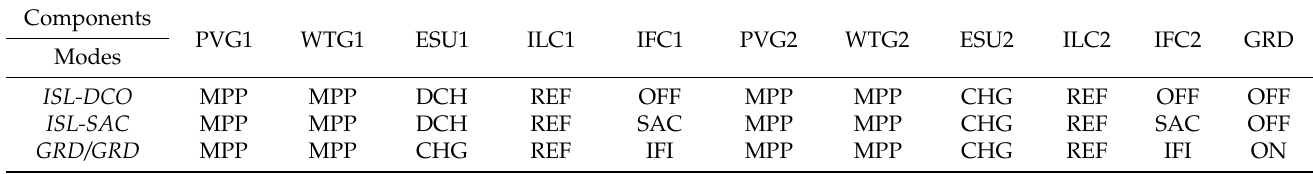
Table 7. Suggested modes of operation for components as a function of the microgrid